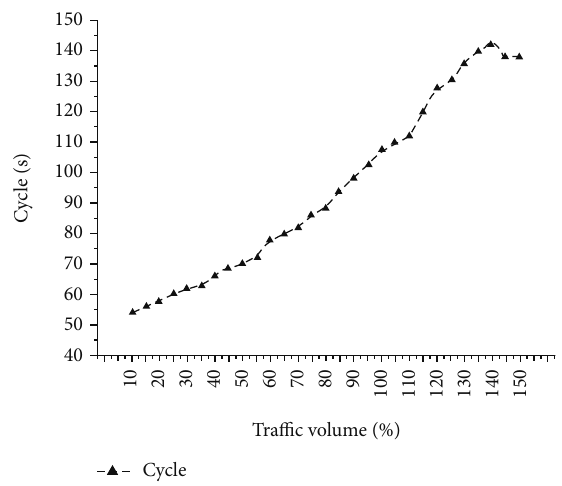
Figure 8: The impact of tra ffi c volume on signal